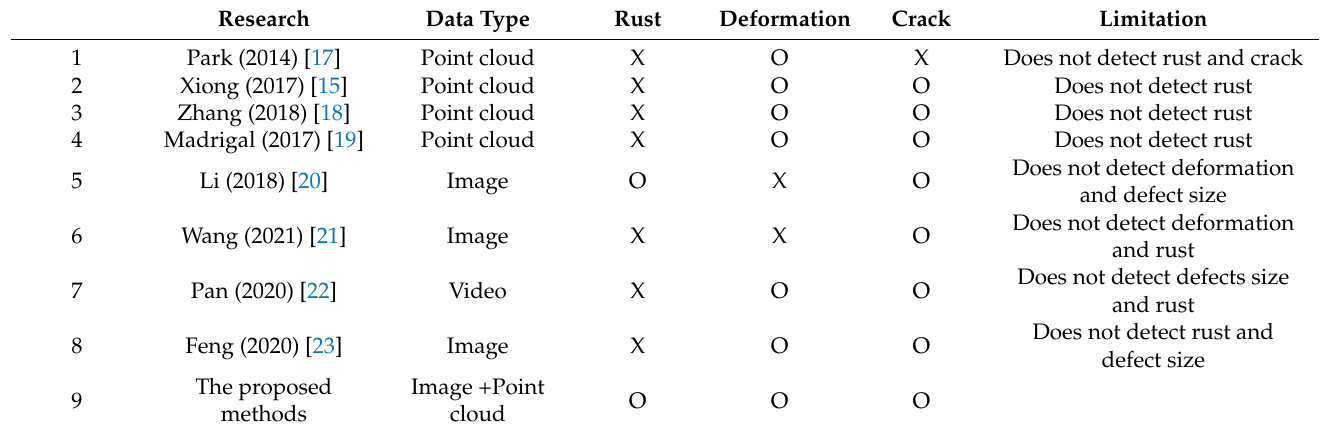
Table 1. A comparison between previous studies and the current study.